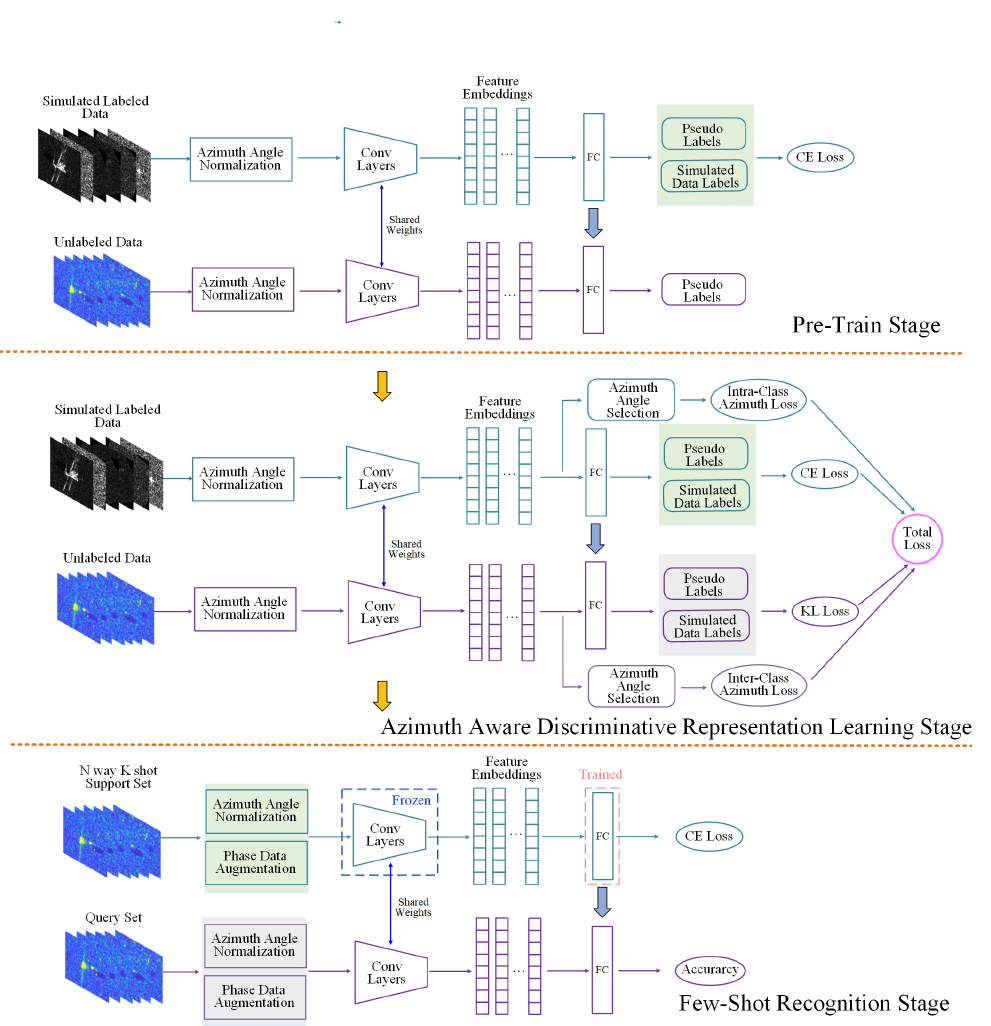
Figure 2. The whole framework of the azimuth-aware discriminative representation framework with regular